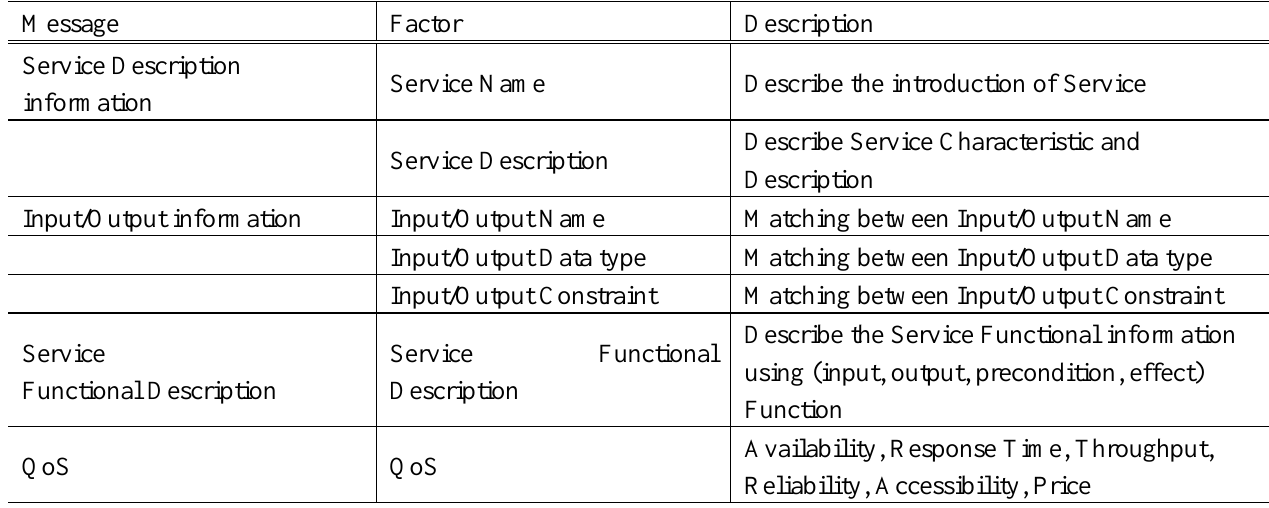
Table 2. Matching Factors of Web